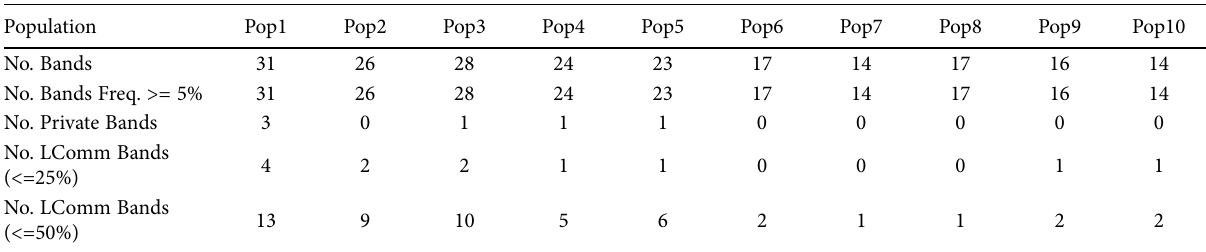
Table 2. ISSR bands in P. afar populations